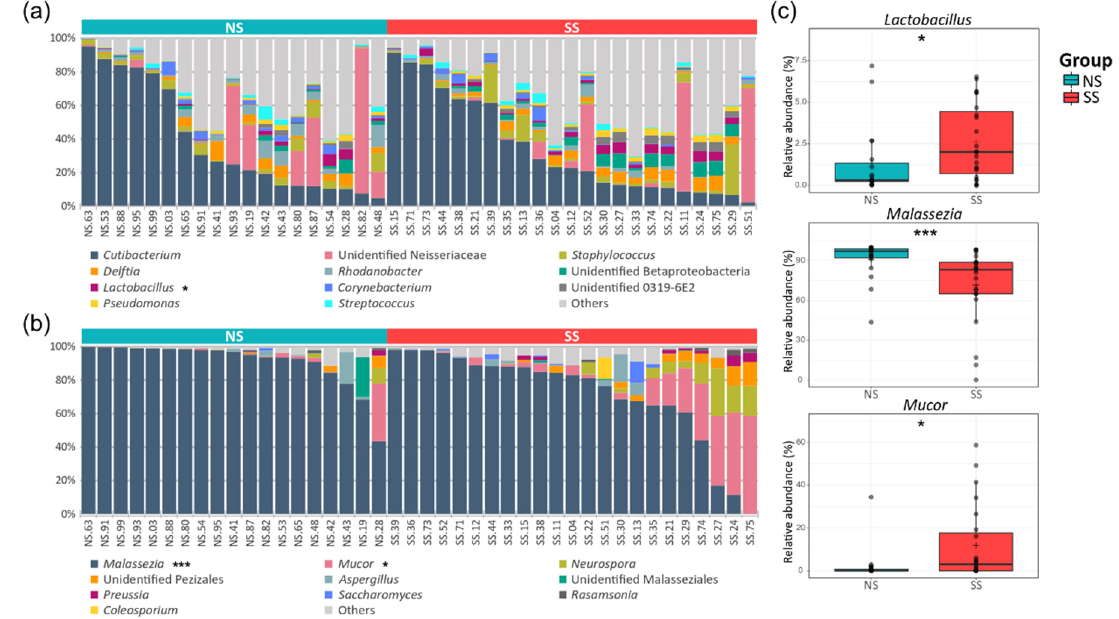
Figure 2. Genus level taxonomic compositions of the bacterial and fungal communities on the skin. The relative abundances of the ( a ) top 11 bacteria and ( b ) top 10 fungi in all the skin samples. ( c ) The genera with significantly different relative abundances between the two skin groups. Detailed information about the relative abundances and phylum levels are provided in Tables S5 and S6. The statistical significance of the differences between the skin groups is indicated by ns > 0.05, * p ≤ 0.05, and *** p ≤ 0.001.